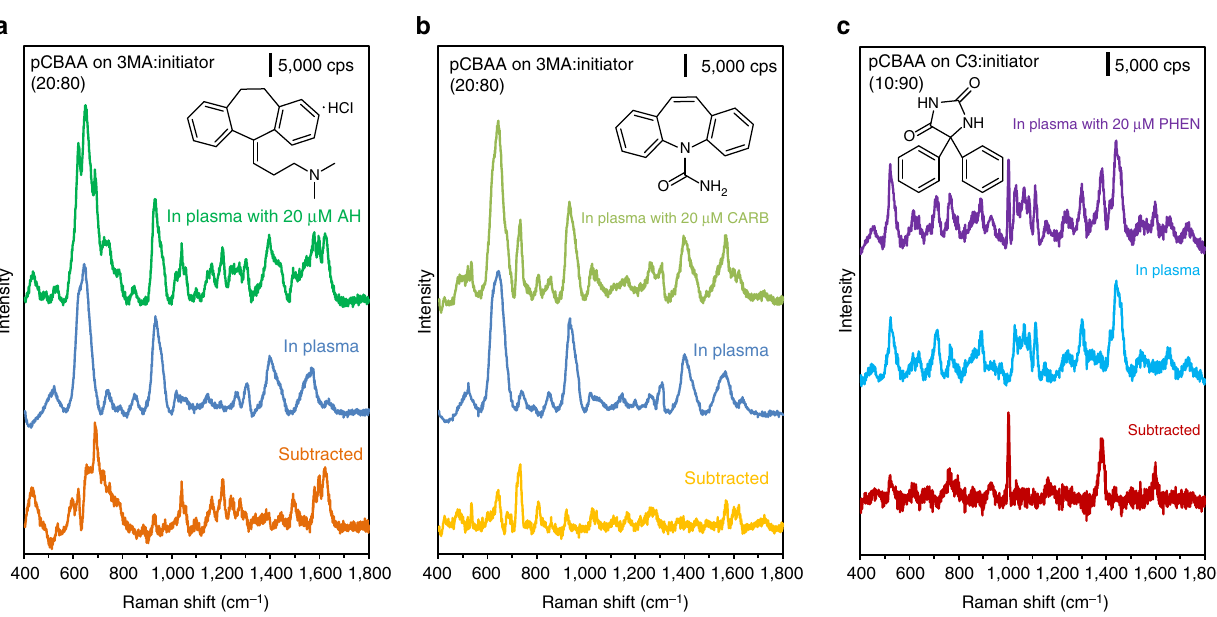
Figure 4 | Hierarchical pCBAA surface modification to attract analytes and enable drug detection in undiluted human plasma. ( a , b ) SERS spectra of 20 m M AH and 20 m M CARB spiked in undiluted plasma (green and olive), plasma (blue) and subtracted spectra (orange and yellow) acquired with the SERS optofluidic system hierarchically modified with pCBAA brushes grafted on the mixed SAM of 3MA and initiator (20:80). ( c ) SERS spectra of 20 m M PHEN spiked in undiluted plasma, plasma and subtracted spectrum acquired with the SERS optofluidic system hierarchically modified with pCBAA brushes grafted on the mixed SAM of C3 and initiator (10:90). l ex ¼ 785nm, P laser ¼ 1mW and t ¼ 30s with three